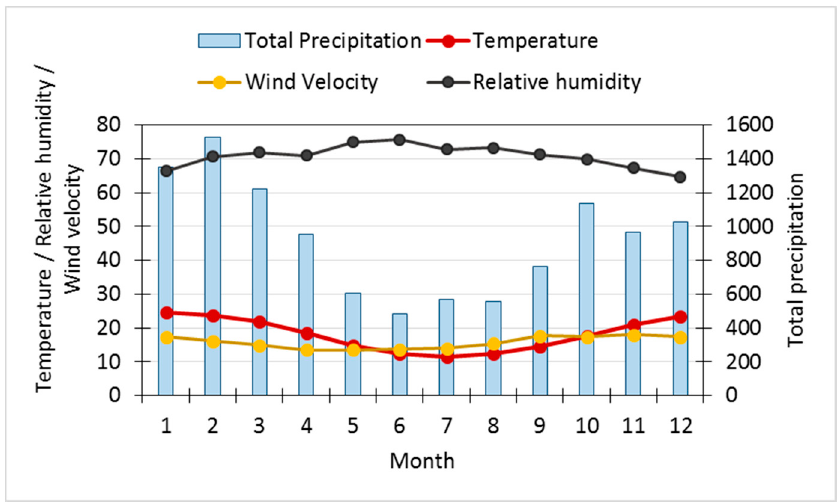
Figure 3. Climate data for Buenos Aires Aeroparque National Meteorological Service station at Aeroparque airport (2003–2013). Source: National Meteorological Service (www.smn.gov.ar).